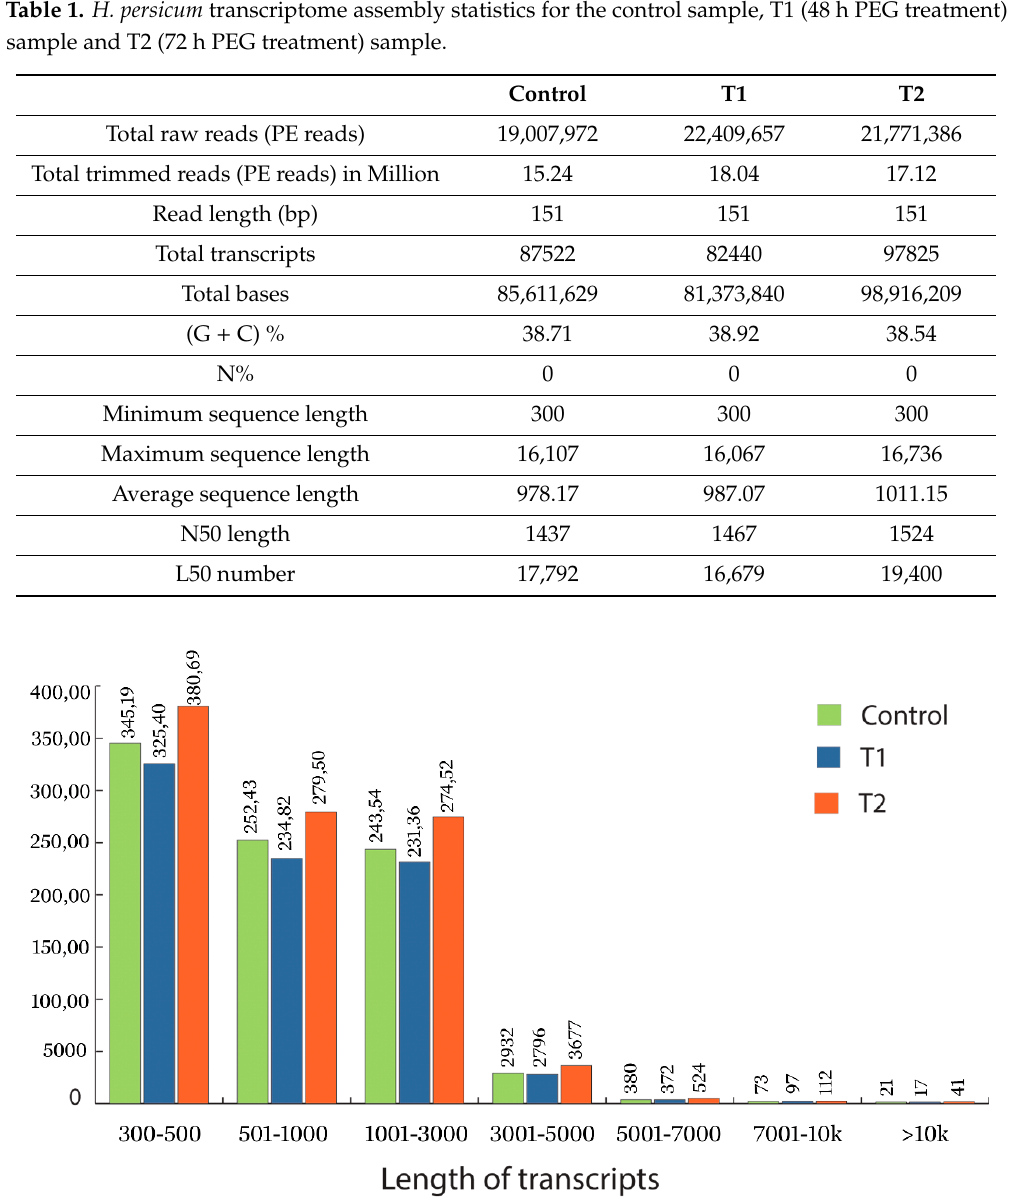
Figure 3. Length of the assembled transcript under di ff erent treatment conditions. Green represents the length distribution of the assembled transcriptome in the control samples of H. persicum , blue represents the length distribution of the assembled transcriptome in T1 (48 h PEG treatment), and red represents the length distribution of the assembled transcriptome in T2 (72 h PEG treatment).